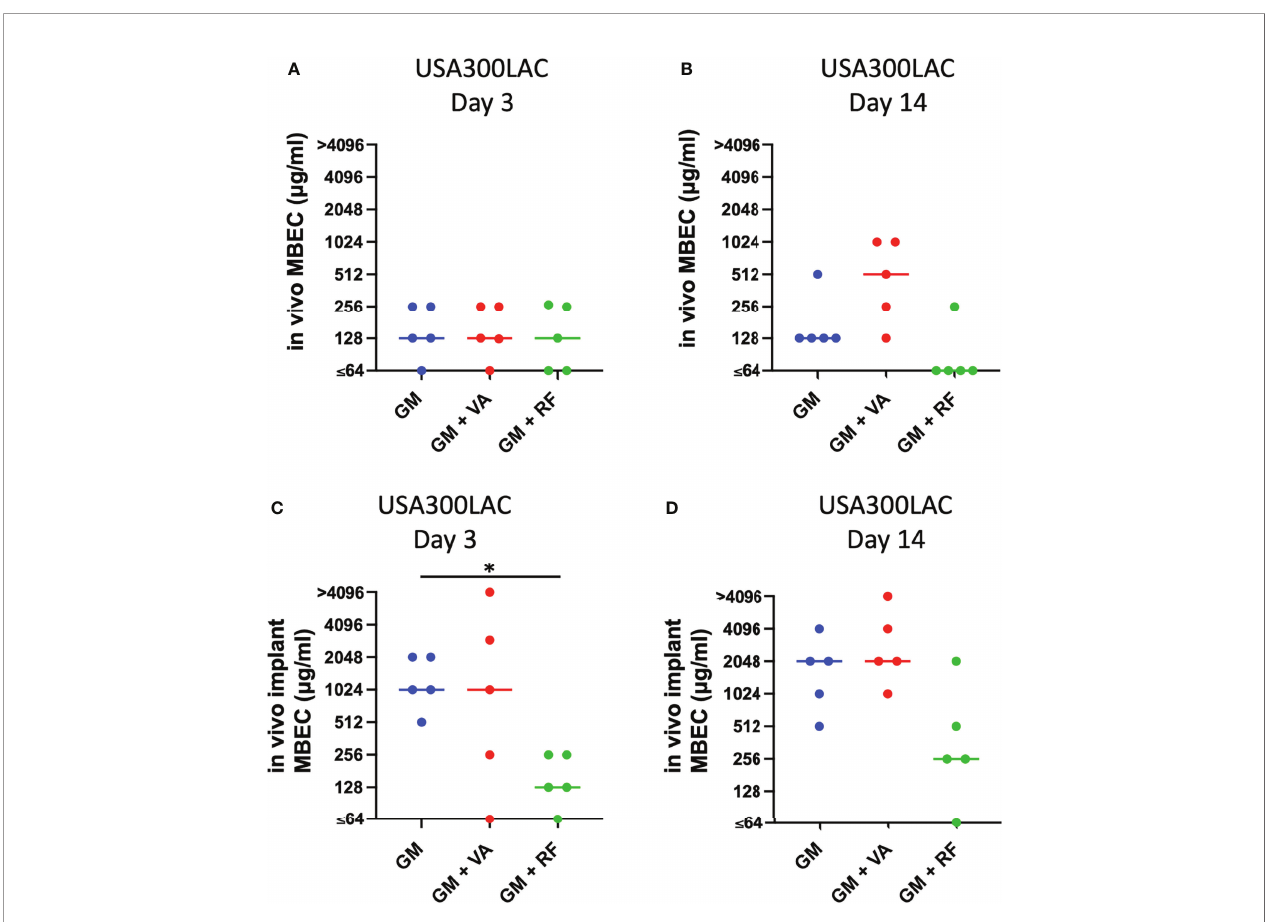
FIGURE 6 | Effect of secondary antibiotics (VA: vancomycin, RF: rifampin) on in vivo minimal bio fi lm eradication concentration (MBEC) of GM (gentamicin) (A, B) and against residual in vivo bio fi lm after vortex-sonication-vortex-method on in vivo implant ( in vivo implant MBEC) in combination with GM (gentamicin) (C, D) Bars in each graph indicate the median of fi ve assays. *: p < 0.05 by Kruskal – Wallis test with Dunn ’ s multiple